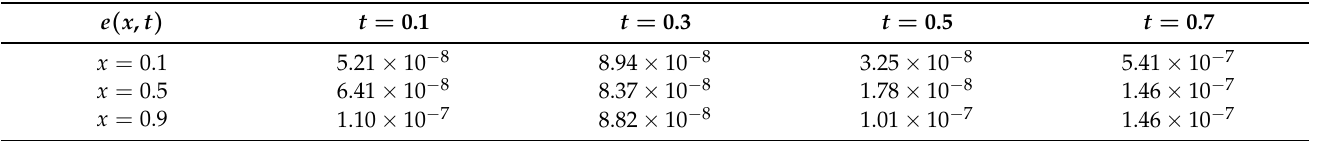
Table 1. Absolute error of each point when α = 0.2.